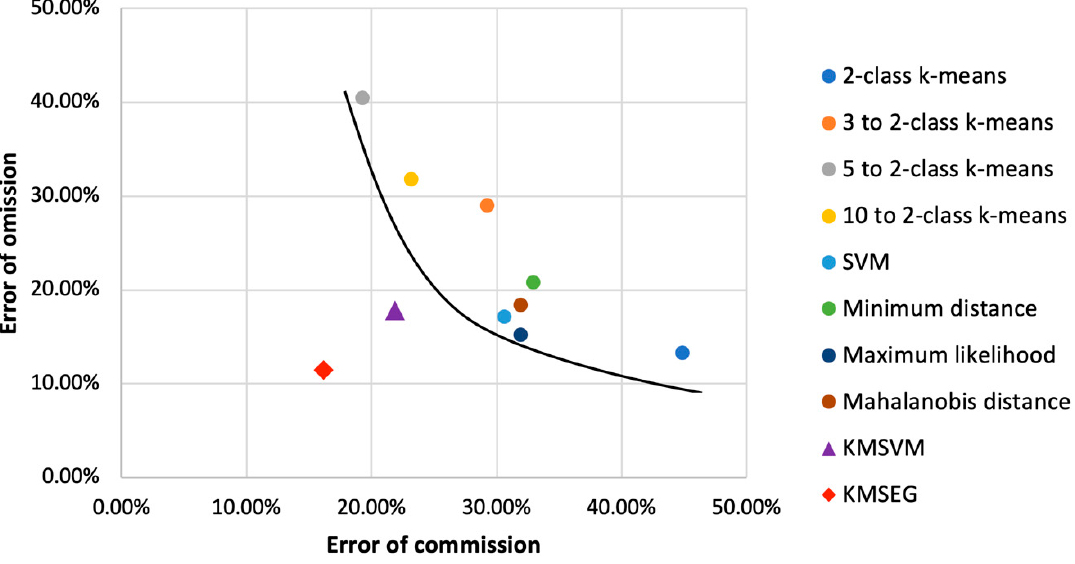
Figure 13. Error of commission versus error of omission for 10 classification methods. The errors of conventional classifications were distributed as a curved trend. The proposed methods KMSVM and KMSEG are superior and lie off the trend line.